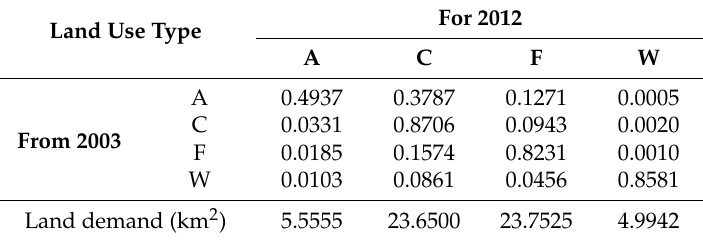
Table 3. Land use transition probability matrix and area